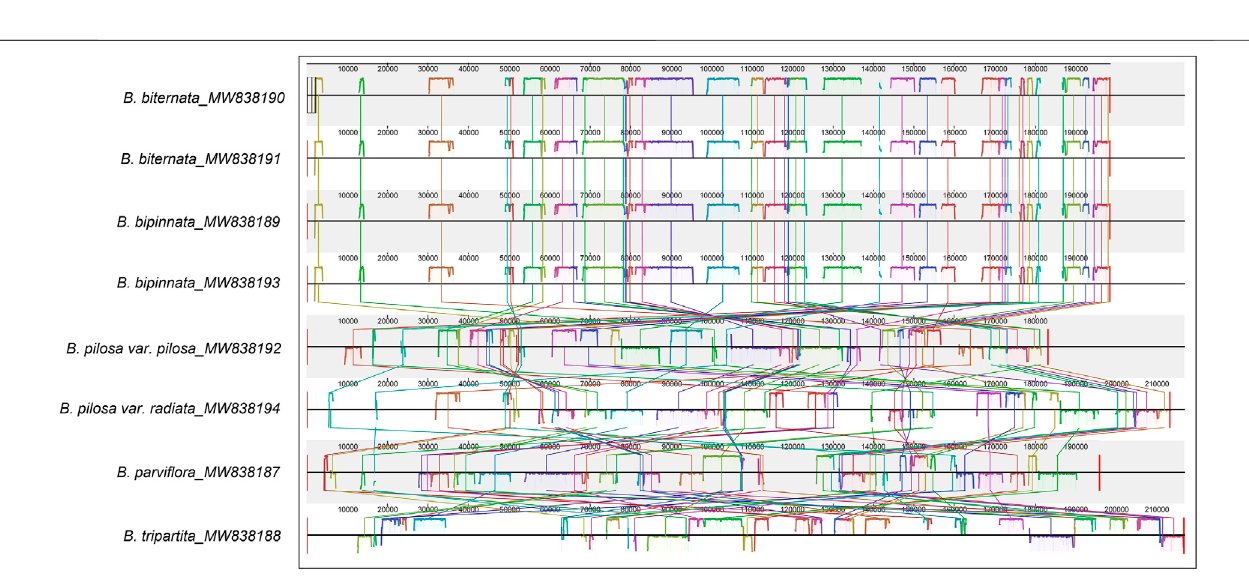
Frontiers in Pharmacology |